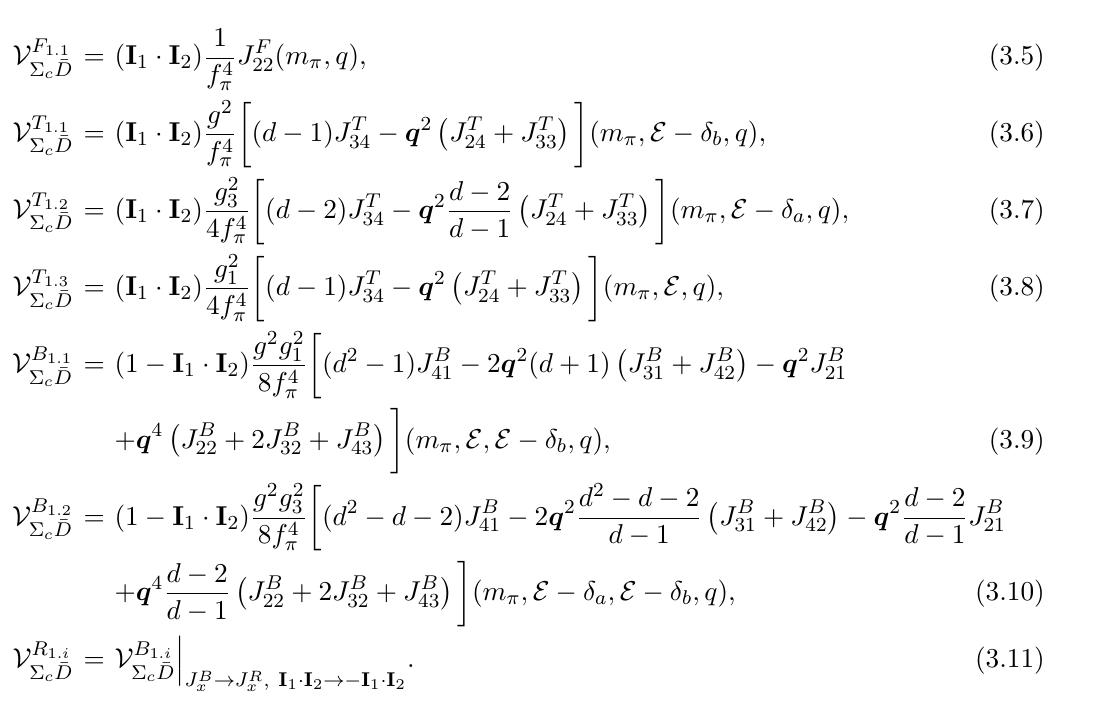
Figure 3 . The two-pion-exchange diagrams of the (cid:6) c (cid:22) D system at O ( (cid:15) 2 ). These diagrams are classi(cid:12)ed as the football diagram ( F 1 : 1 ), triangle diagrams ( T 1 :i ), box diagrams ( B 1 :i ) and crossed box diagrams ( R 1 :i ). The internal heavy baryon lines in diagrams ( T 1 : 3 ), ( B 1 : 1 ) and ( R 1 : 1 ) can